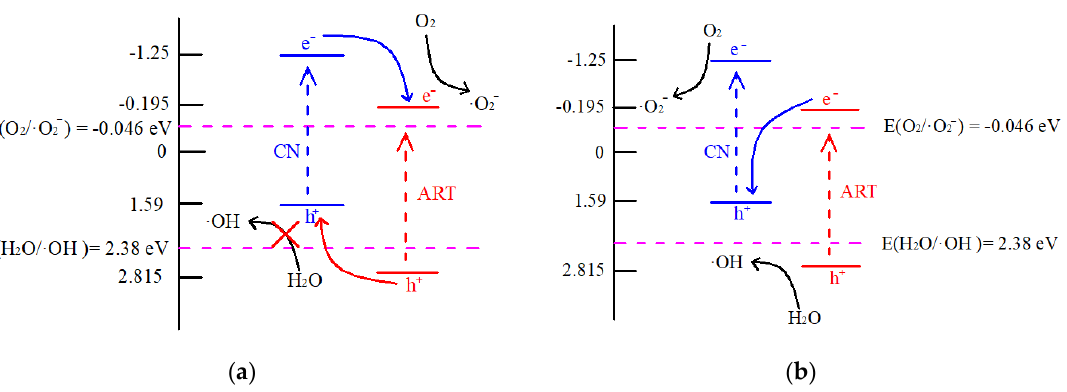
Figure 9. Charge transfer mechanism of the photocatalytic degradation conventional type II hetero- junction ( a ) and Z-type heterostructure ( b ). junction ( a ) and Z-type heterostructure ( b ).